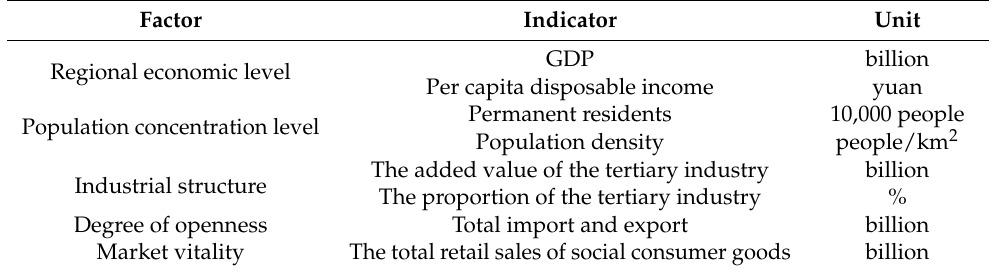
Table 3. Influencing factors indicators of the characteristics of the catering industry in the YRD.